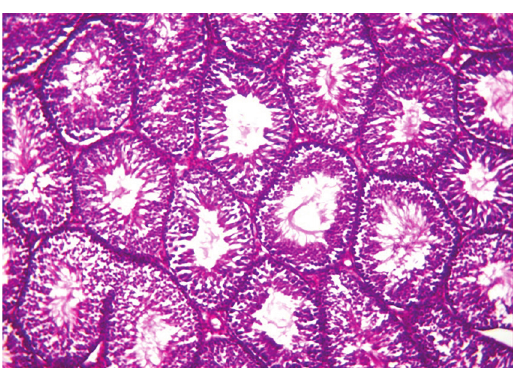
cells of Leydig (ICL)